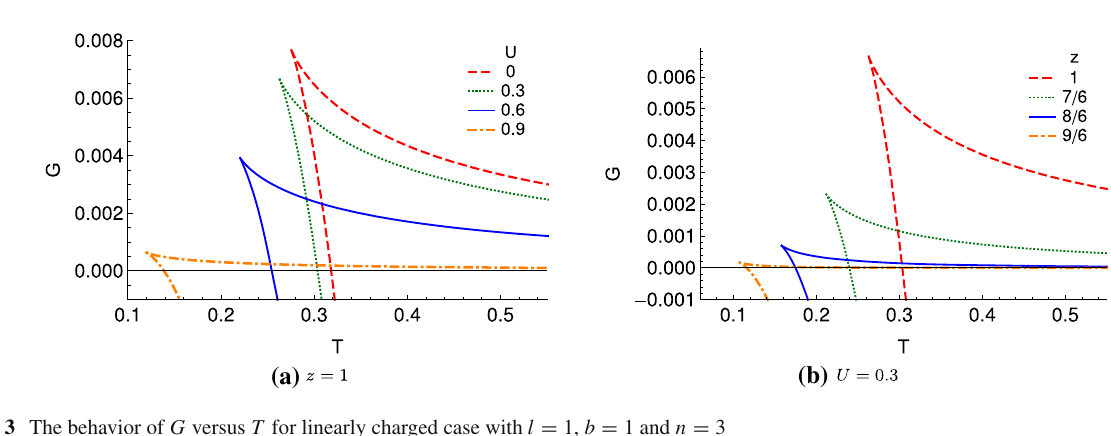
Fig. 2 The behavior of T versus S for l = 1, b = 1